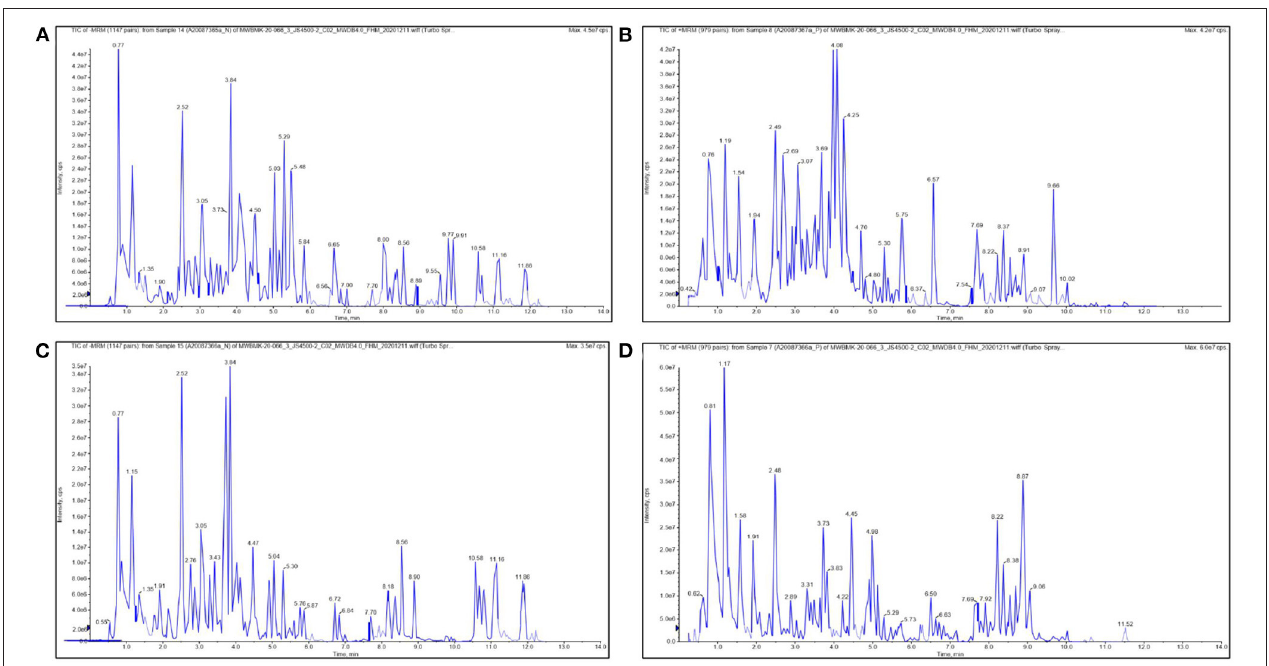
FIGURE 1 | The chromatographic pictures of UHPLC-QQQ-MS-based metabolomics. [ (A) negative ion for SRO; (B) positive ion for SRO; (C) negative ion for SRT; (D) positive ion for